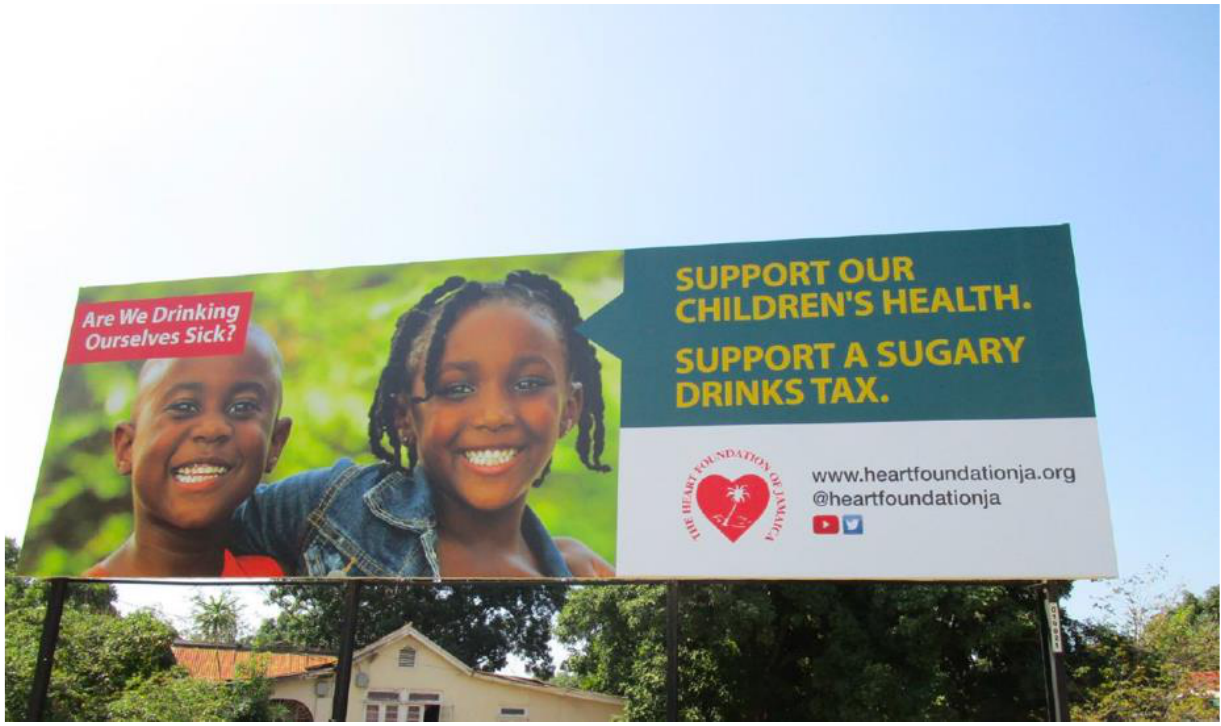
Figure 2. Billboard in St. Andrew, Jamaica, 2019 —“Are We Drinking Ourselves Sick?” (Phase IV).